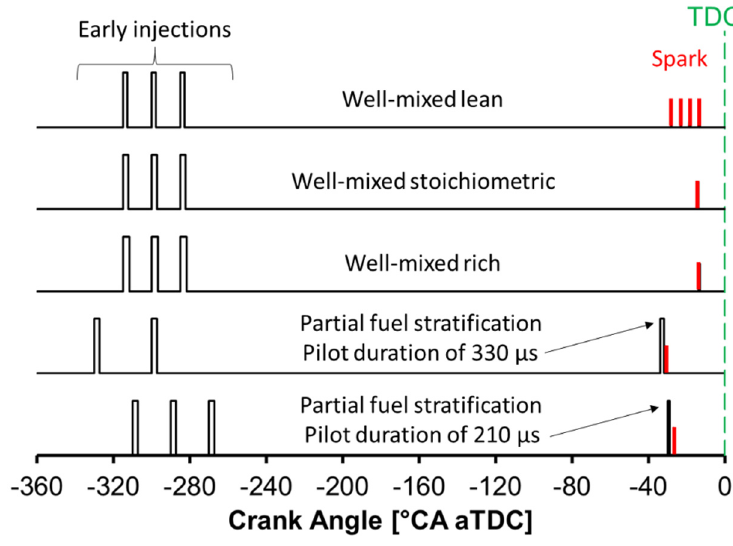
Figure 4. Timing of events in the selected engine operating conditions.